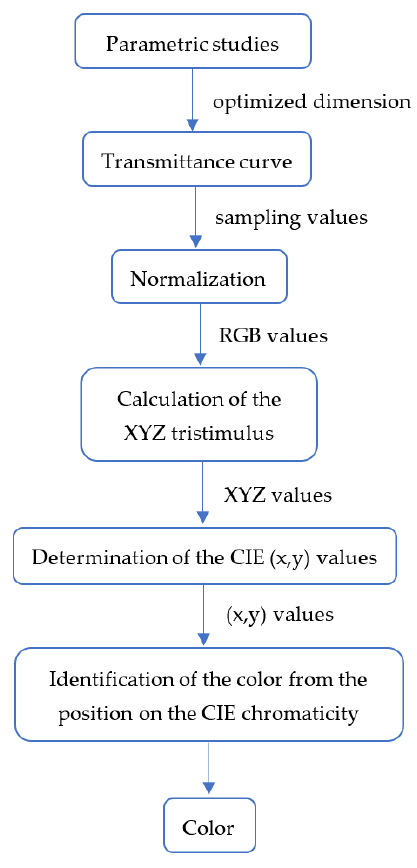
Figure 11. The proposed color analysis process.